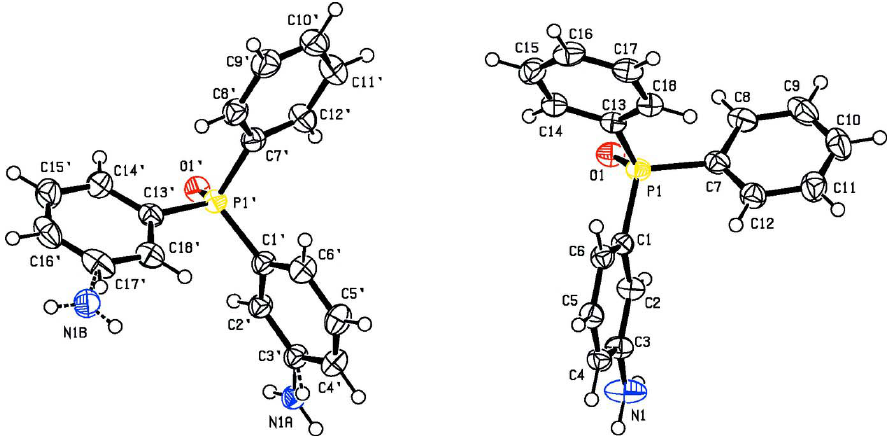
The molecular structure of the title compound, showing the atom-numbering scheme and displacements. Ellipsoids are drawn at 50% probability level. 2-propanol groups are removed for clarity. N1A and N1B atoms are disordered and occupancies of positions of atoms N1A and N1B are 0.75 and 1/4,